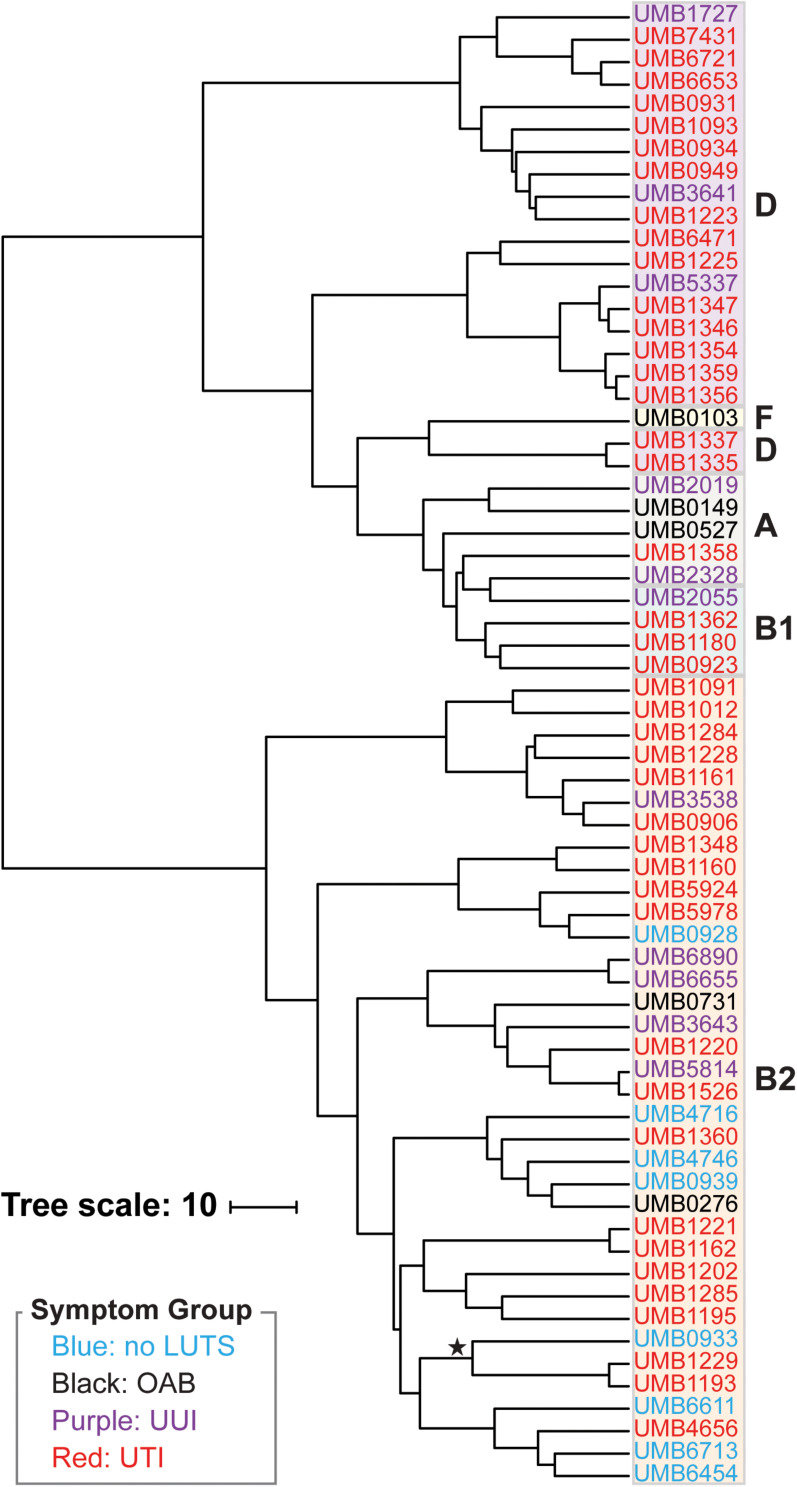
Hierarchical clustering of the 66 E. coli genomes based on gene content. Symptom groups are indicated by color. Phylotypes are indicated by the colored boxes. The branch labeled with a star indicates the 3 isolates of the subphylotype B22.